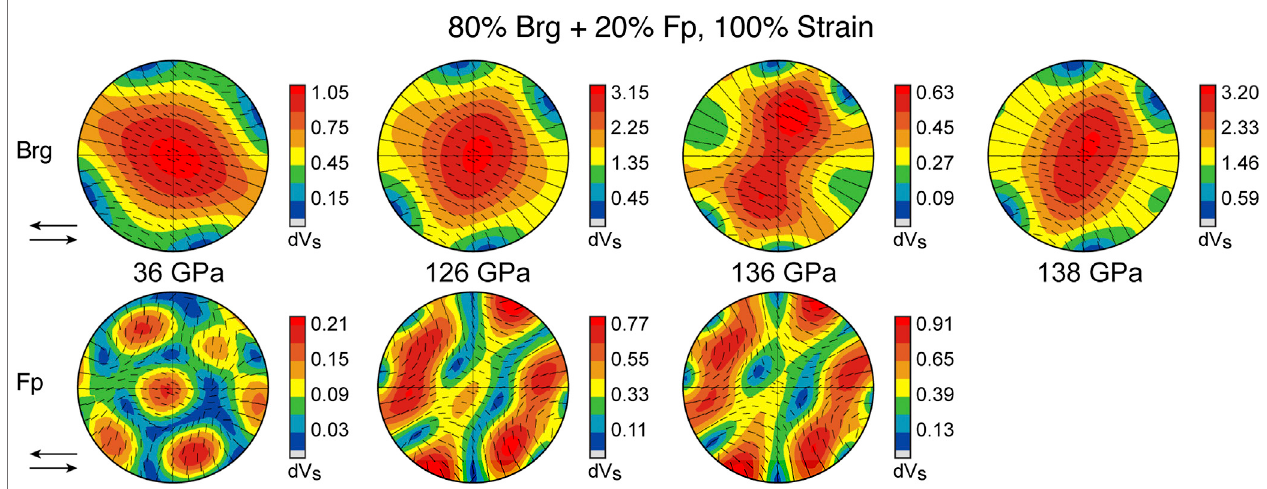
FIGURE12| Percentshearwavesplitting( δ V S )forthecaseof100%strain.Thetoprow(Brg)showsrandomferropericlaseorientationsandtexturedevelopmentin bridgmanite. The bottom row (Fp) shows random bridgmanite orientations and texture development in ferropericlase. Both rows assume a lower mantle composition of ∼ 80% bridgmanite and ∼ 20% ferropericlase. Sense of shear is top left, shown by the arrows. Eigenvectors of the fast S-wave polarization are shown as black dashes. Note that each hemispheric projection shows a different range of δ V S .